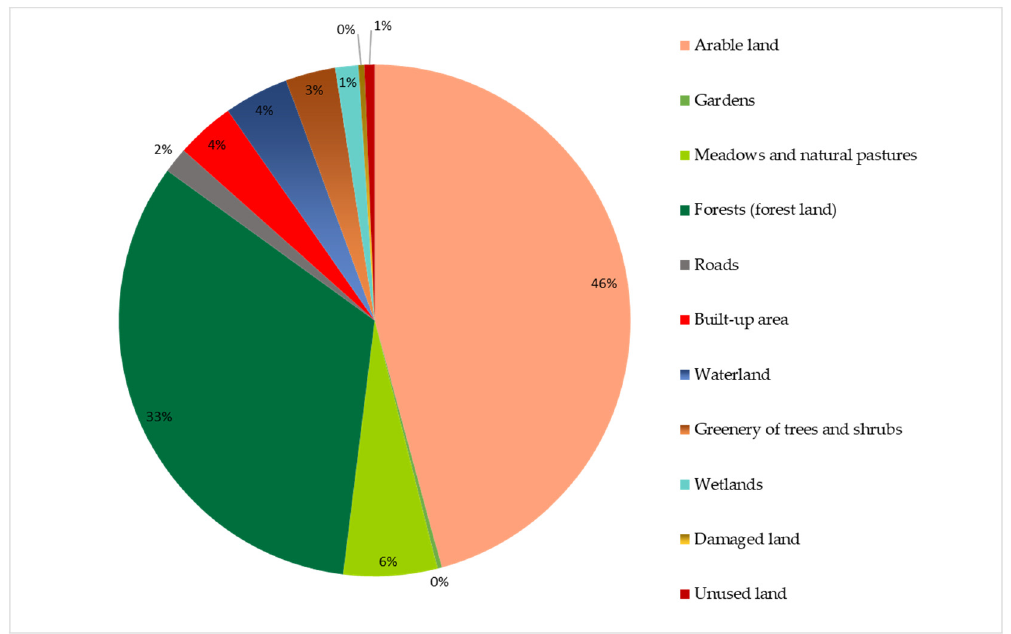
Figure 1. Study area and distribution by land use in Lithuania (Data from Land Information System https://zis.lt/statistika/zf/, (accessed on 2 April 2022).